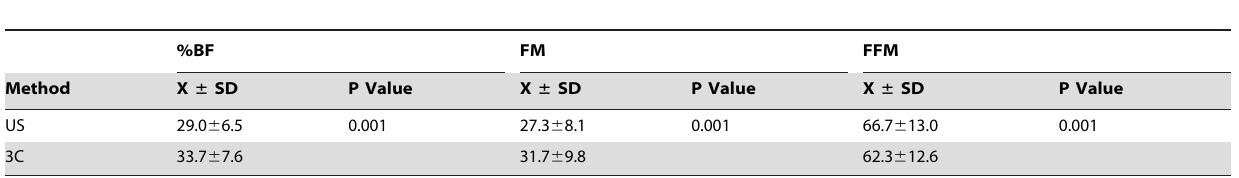
Table 2. Comparison of percent body fat (%BF), fat mass (FM) and fat free mass (FFM) between the ultrasound (US) and 3- compartment model (3C). (Mean 6 SD).